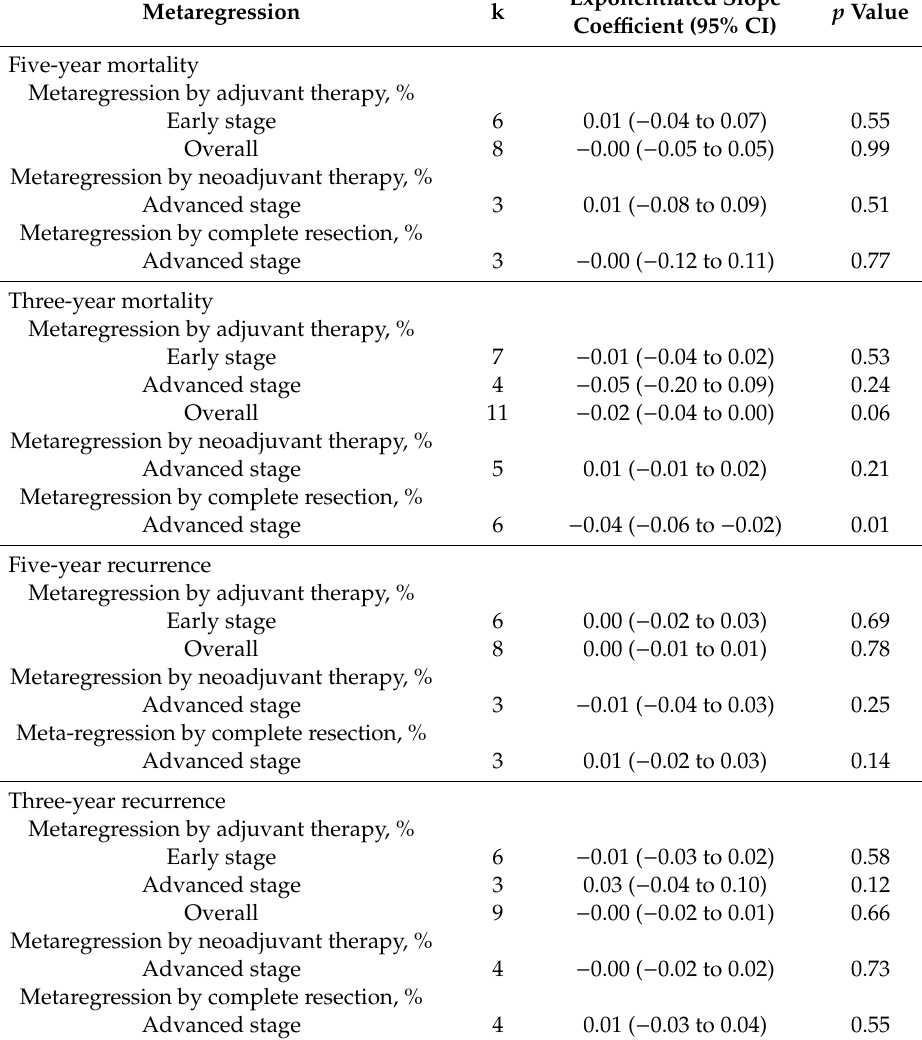
Table 2. Metaregression